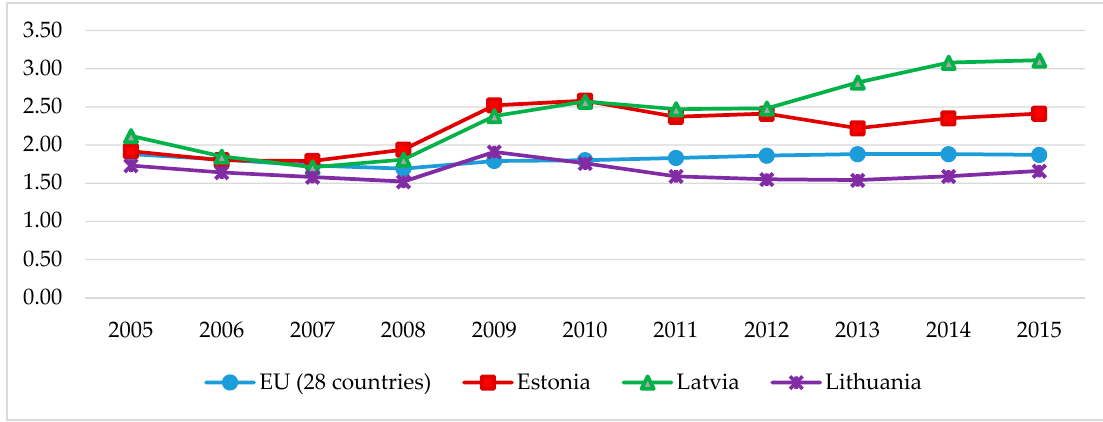
Figure 3. Dynamics of revenues from energy taxes in the Baltic States, as the percentage of GDP.